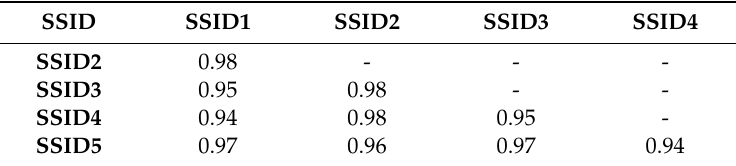
Table 3. The spatial Correlation coefficient between MSSIDs’ signals over AOI.